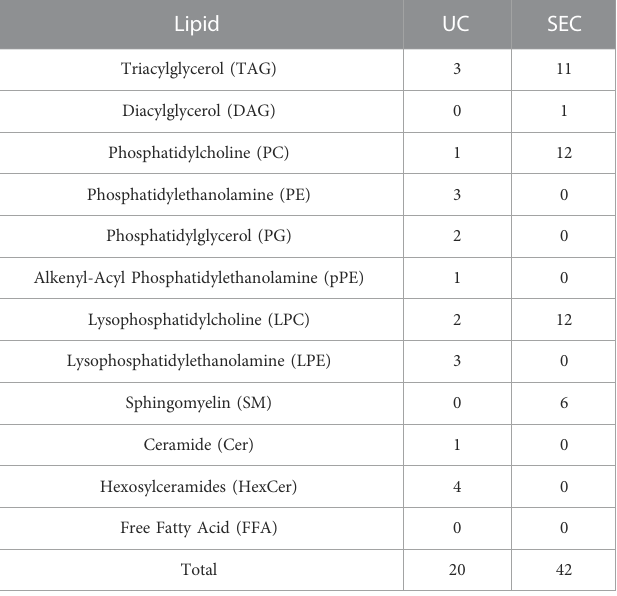
TABLE 1 Number of lipids that signi fi cantly varied between UC and SEC recovery